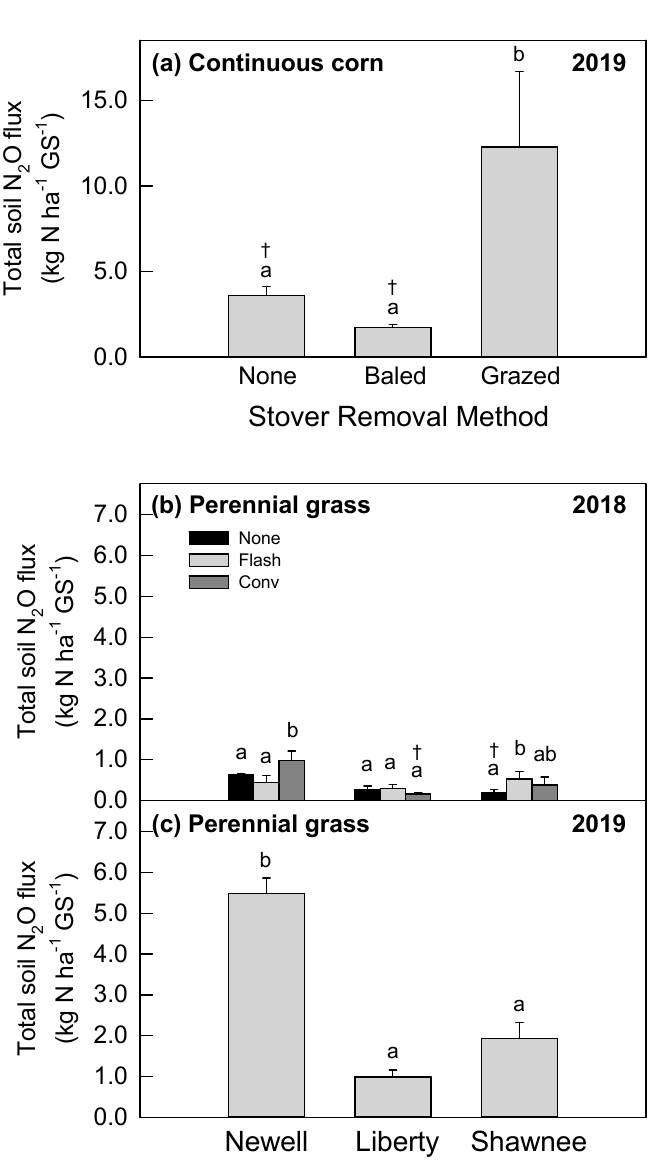
Figure 2. Total growing season (GS) soil N 2 O emissions for 2019 continuous corn ( a ), 2018 perennial grass ( b ), and 2019 perennial grass ( c ) (GS; April 1–October 31). Different lower-case letters in panels ( a , c ) denote significant stover removal method or grass type differences, respectively ( p ≤ 0.05). In ( b ), different lower-case letters indicate significant grazing treatment differences within each grass type. None = non-grazed, Flash = flash grazed, Conv = conventionally grazed. Symbols (†) indicate soil N 2 O fluxes not significantly different from zero.